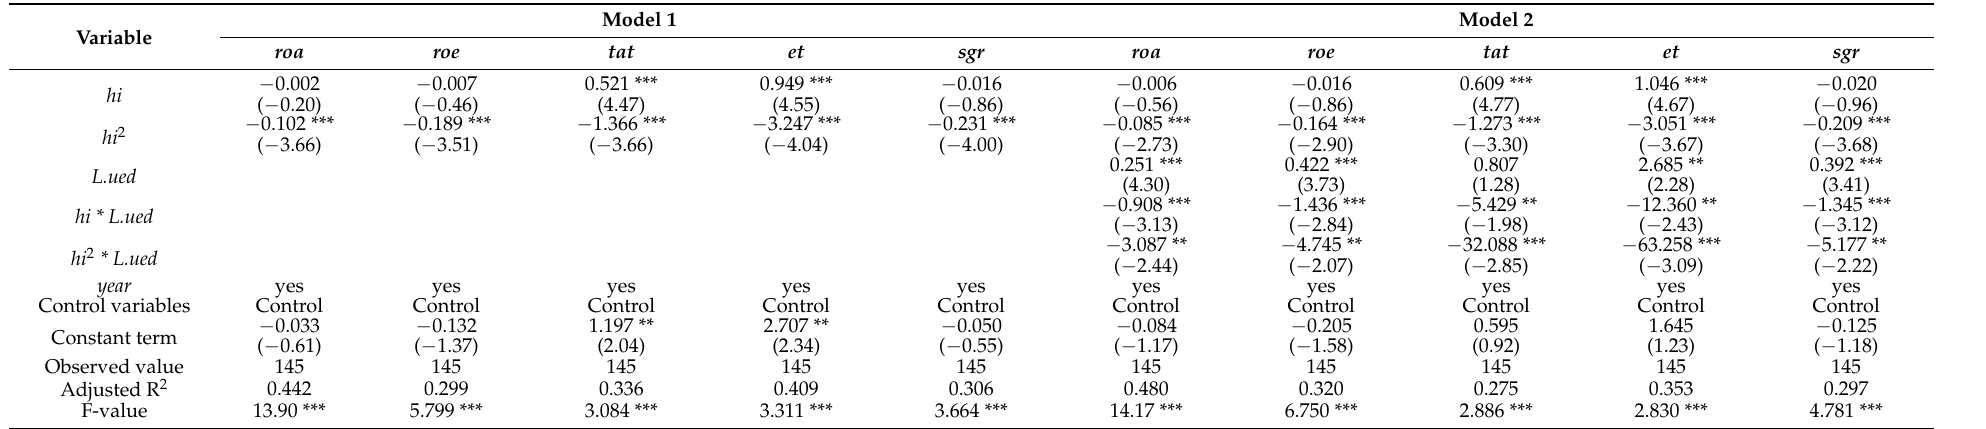
Table A1. Robustness test 1.